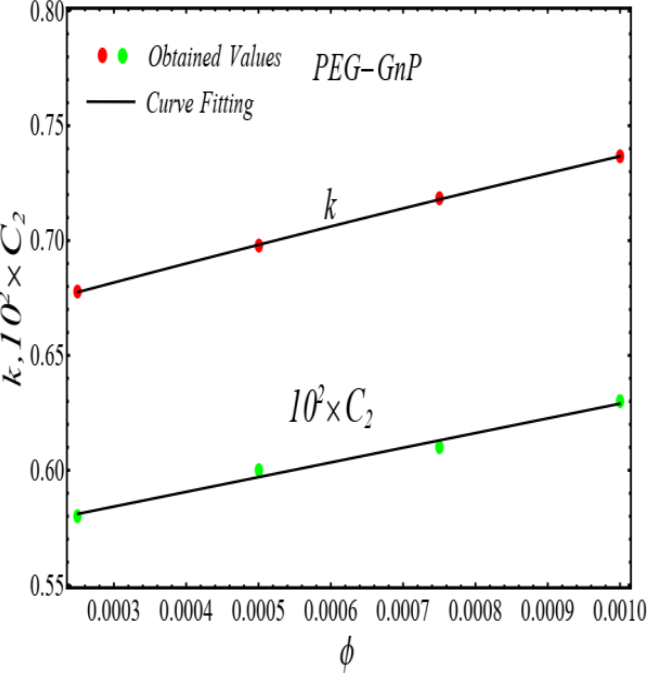
Figure 16. Fitting of the Equation (4) for parameters listed in Table 3.